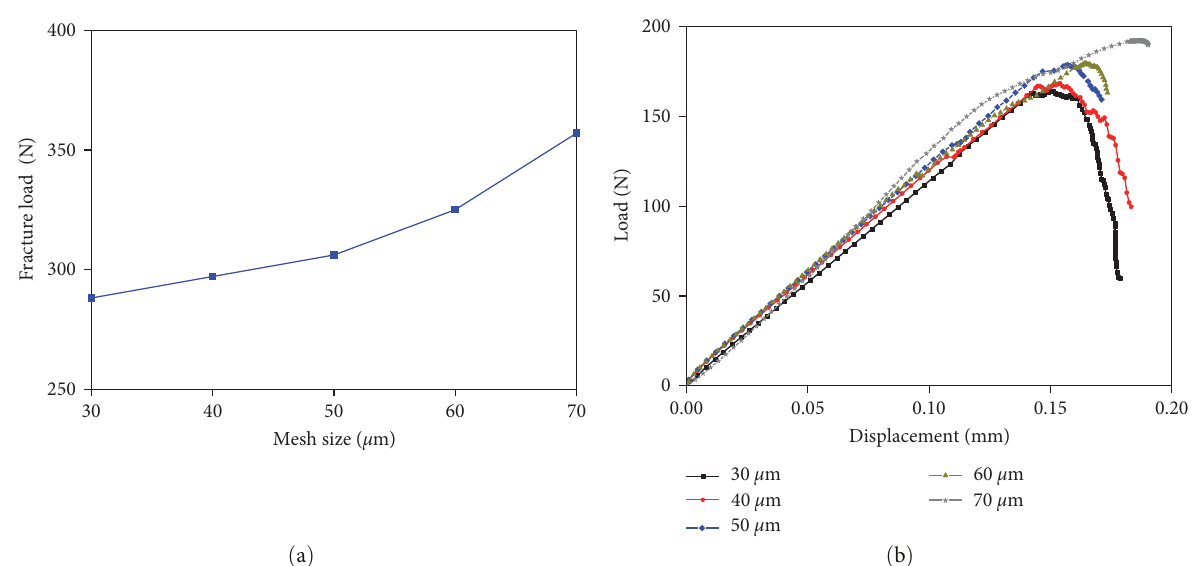
F IGURE 2: Mesh sensitivity analysis for the femoral cortical bone fi nite element models: (a) simulation in the compression condition; (b) simulation in the three-point bending